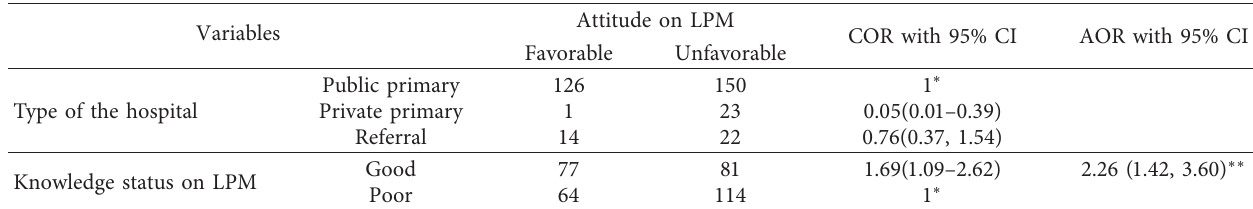
Table 4: Factors associated with attitude on LPM among SBAs working at hospitals in Gondar zones, northwest Ethiopia, 2019.